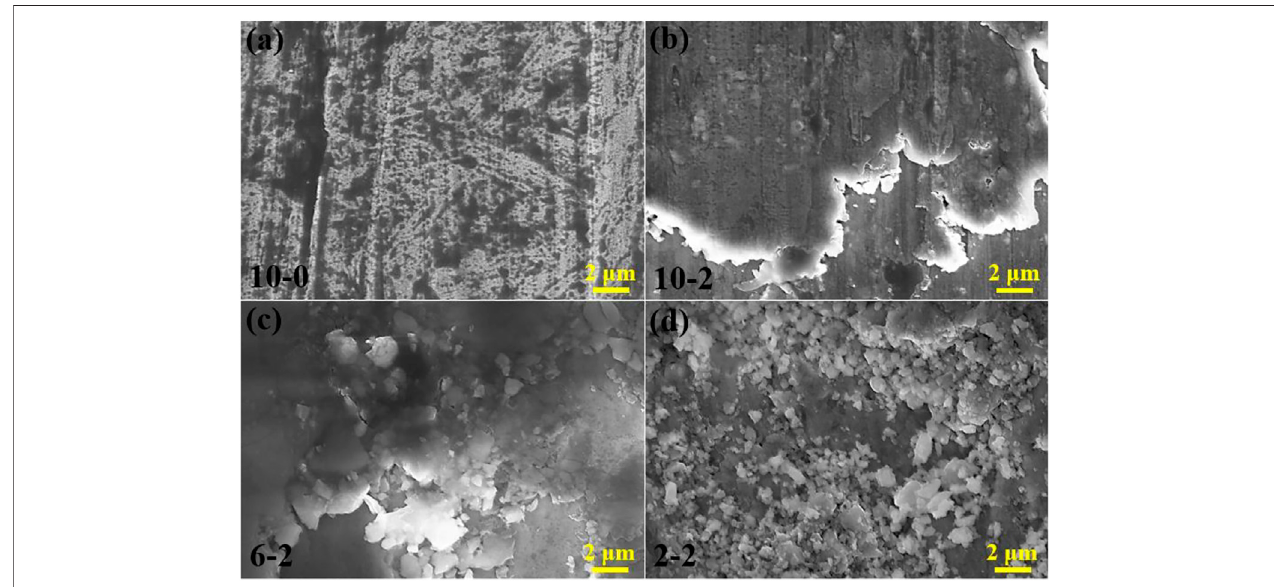
FIGURE 11 | Local surface morphology of the wear tracks in the four typical samples. (A) The 10 – 0 sample; (B) the 10 – 2 sample; (C) the 6 – 2 sample; and (D) the 2 – 2 sample.